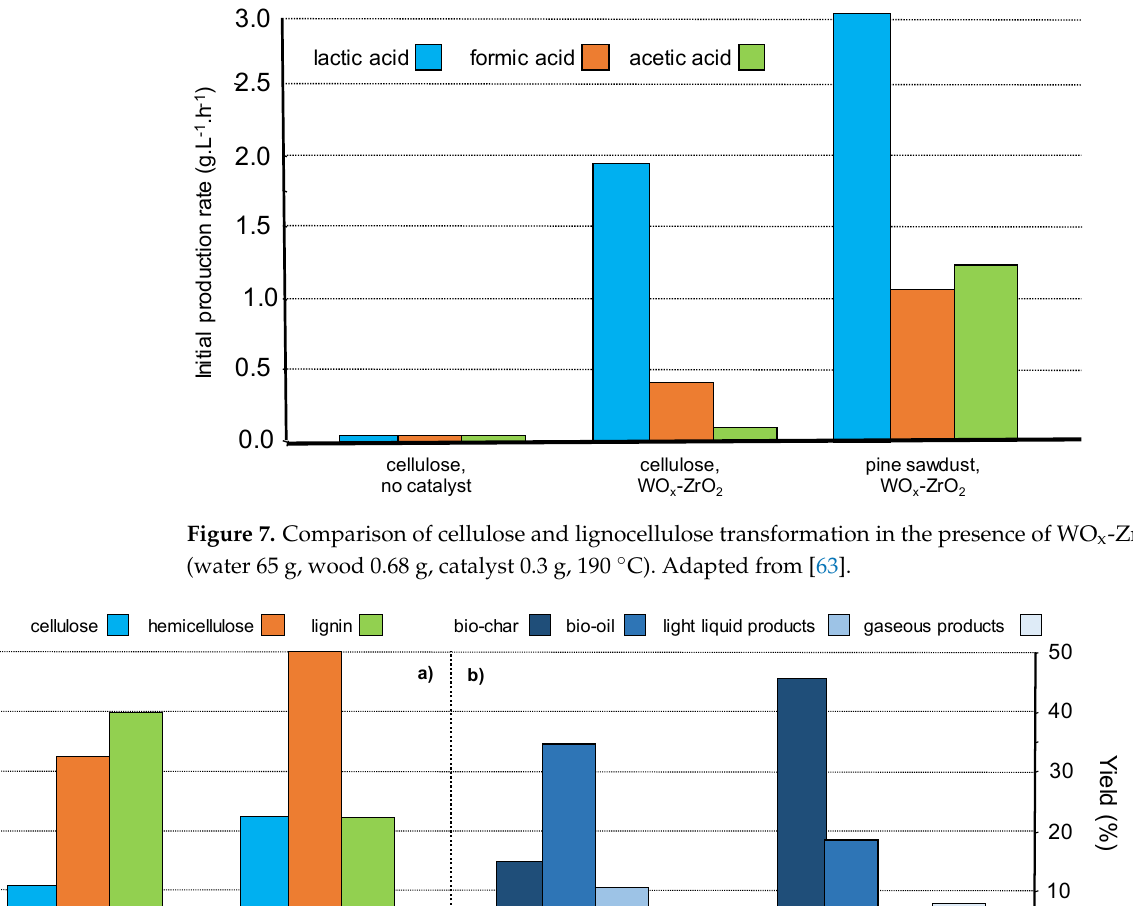
Figure 9. Pine wood conversion in supercritical ethanol at 250 °C. Influence of the fluid density on the yields of bio-char, bio-oils, light products, and gases, in the absence of catalyst. Adapted from [100]. In the absence of catalyst, the selective formation of liquid light products was clearly not favoured, and the conversion/liquefaction mainly produced bio-oil up to 30 wt% of initial substrate, using supercritical ethanol for example. This is why the transformation strategy can also include the presence of a catalyst, at the early stage of the fractionation, in order to drive a liquefaction into the formation of a specific product. Some possibilities are presented in Figure 10. Studies are currently in progress in the team to determine the influence of the characteristics of various solvents and catalyst on the sequential lignocellulose component liquefaction and the nature and composition of the products [101].